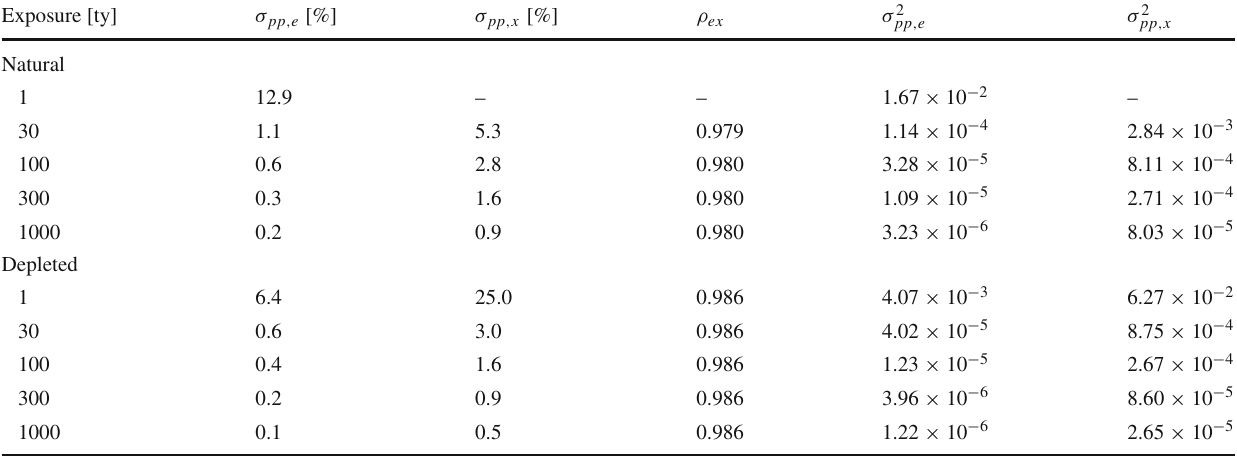
sures and two target compositions: natural 136 Xe abundance and deple- tion by two orders of magnitude. The fiducial mass of DARWIN is assumed to be around 30 t